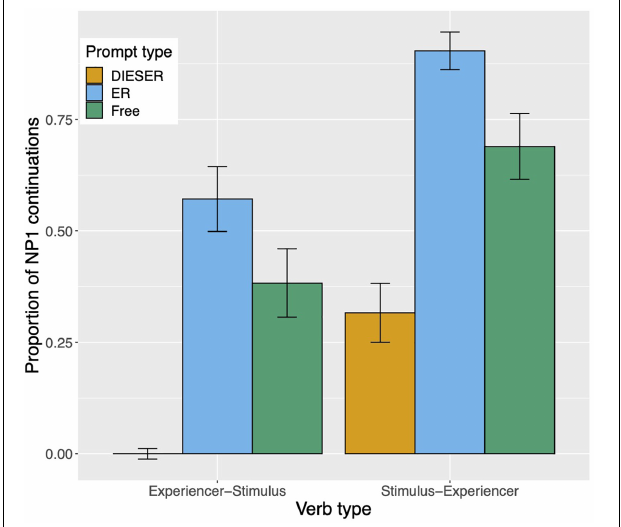
FIGURE 5 | Proportion of NP1 continuations per prompt condition ( er, dieser, and free ) and verb type in Experiment 2. The NP1 continuations represent the next-mention bias for NP1. Error bars represent 95% confidence intervals based on normalized data following Morey (2008) and Chang